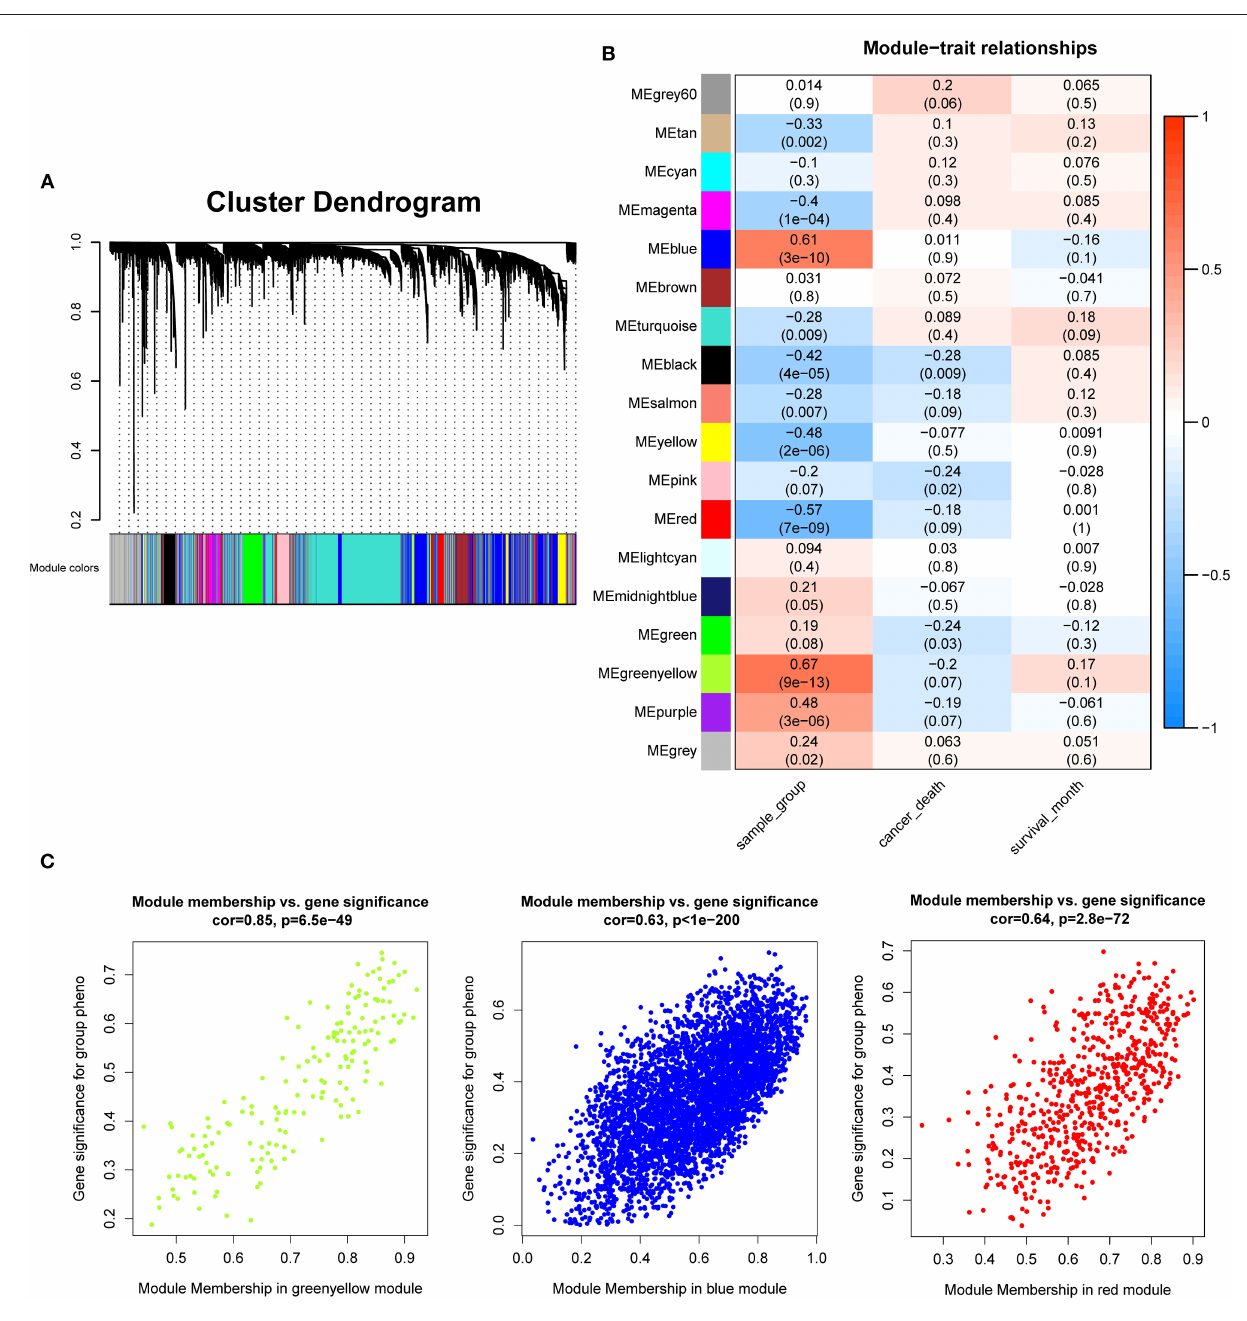
FIGURE 3 | Identification of modules associated with the clinical traits of pancreatic cancer. (A) Dendrogram of 18,830 genes clustered based on a dissimilarity measure (1-TOM). (B) Heatmap of the correlation between module eigengenes and clinical traits of pancreatic cancer. (C) Module membership vs. gene significance in “greenyellow,” “blue,” and “red”